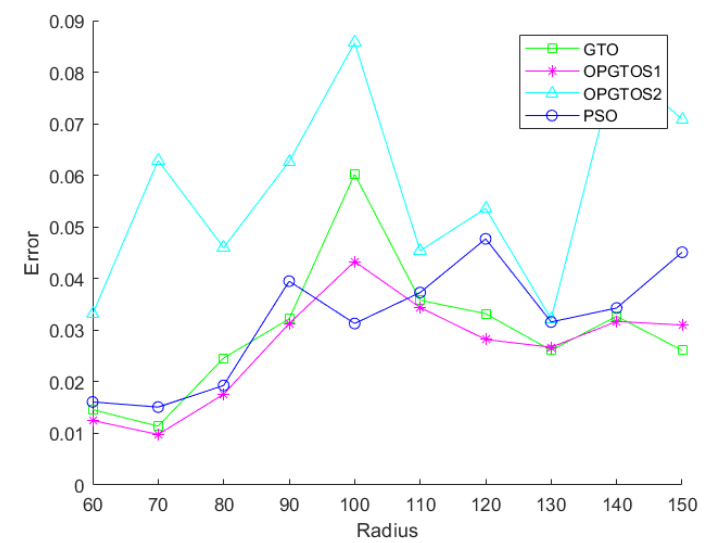
Figure 12. The localization error of PSO, GTO, OPGTOS1 and